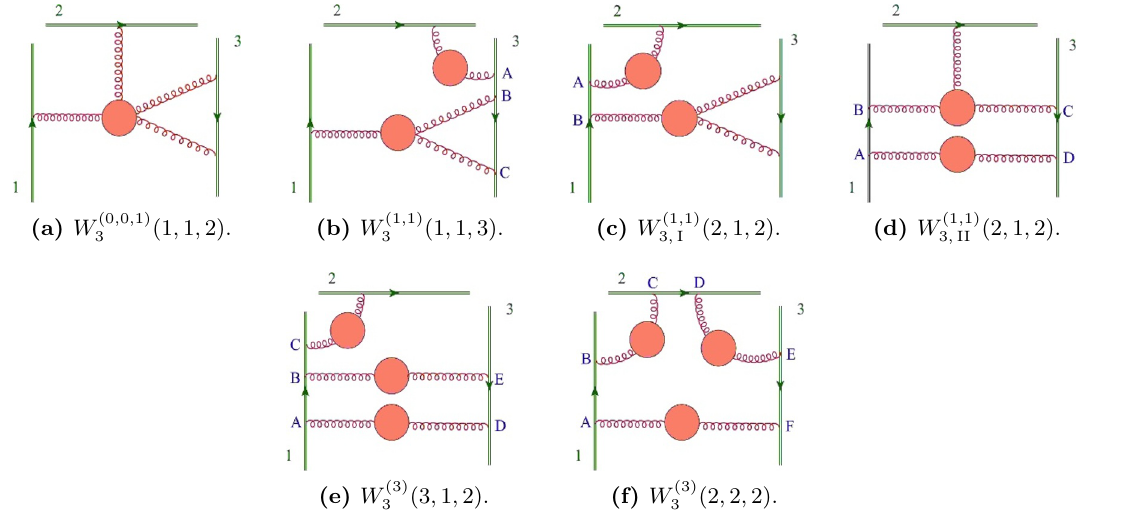
Figure 2. Representative skeleton diagrams for the six three-loop Cwebs connecting three Wil- son lines in a massless